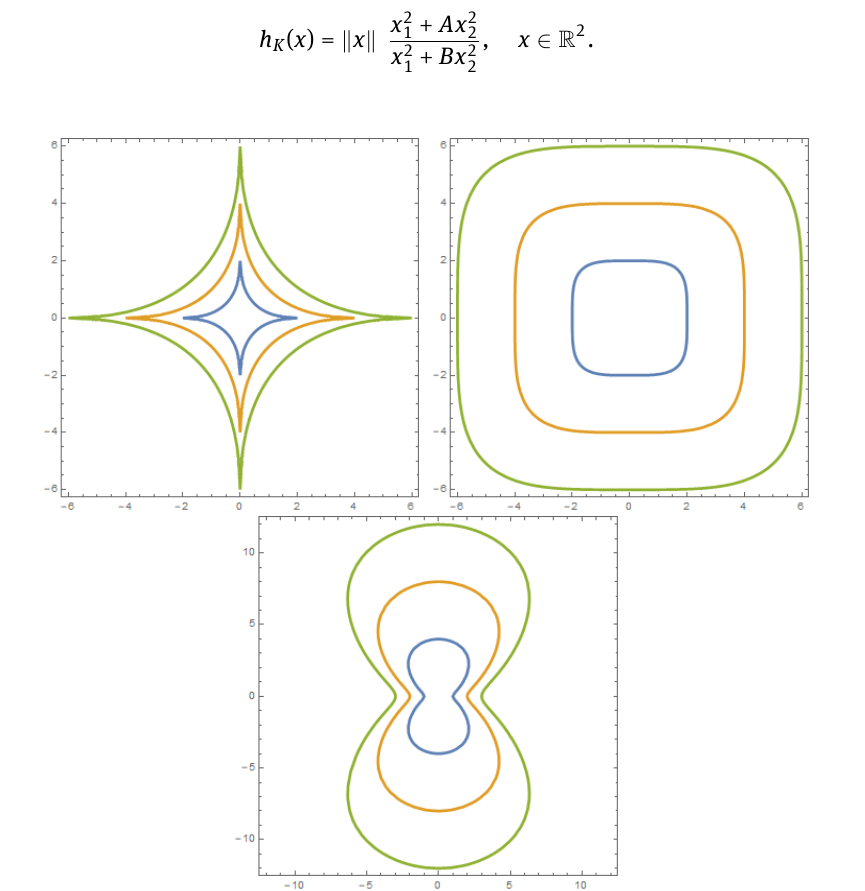
Figure 5: model class 1, h K according to (24). left: contour curves of h for p = 1 2 , A , B = 0 , right: for p = 4, A , B = 0 , bottom: for p = 4, A = 1, B =